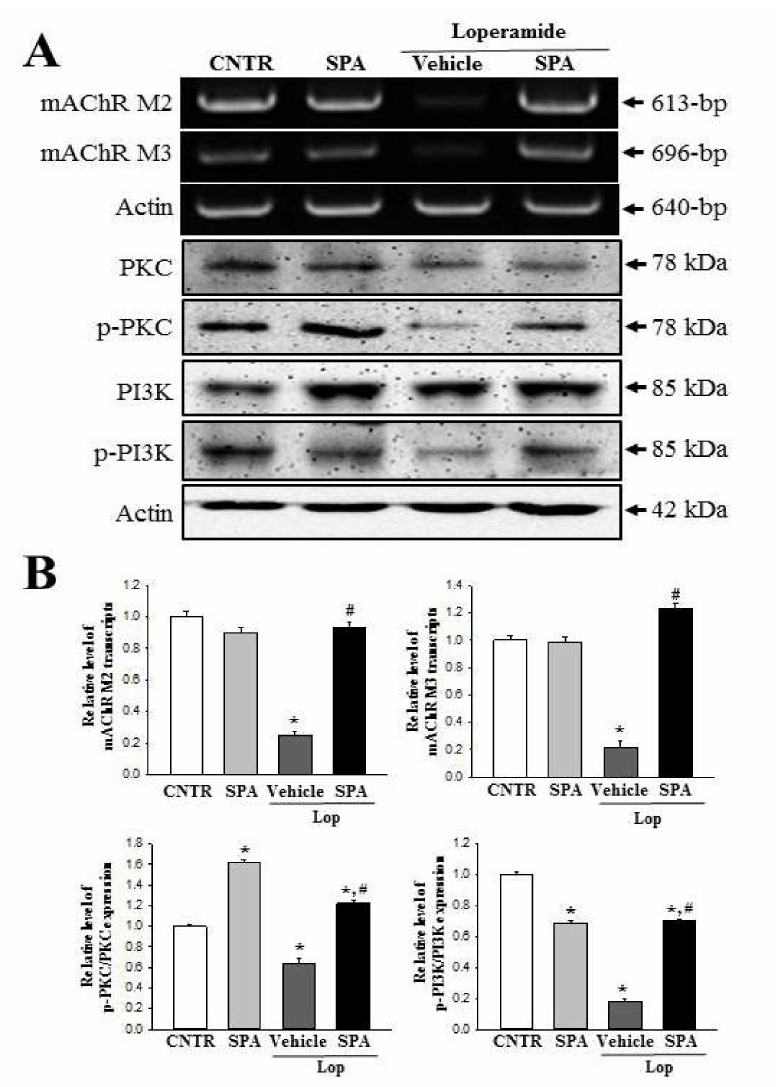
Figure 9. The expression of mAChRs and key mediators within their downstream signaling pathway in the colon after SPA treatment: ( A ) Resulting image of RT-PCR and western blot analyses. The levels of mAChR M2 and M3 transcripts in the total mRNA of colons were measured by semiquantitative PCR using specific primers. After the intensity of each band was determined using an imaging densitometer, the relative levels of mAChR M2 and M3 were calculated based on the intensity of actin. The expression of several related proteins, including PKC, p-PKC, PI3K, and p-PI3K, in the mAChR M2 and M3 signaling pathway were measured by a Western blot analysis using the HRP-labeled anti-rabbit IgG antibody. ( B ) Relative level of each protein expression. After the intensity of each band was determined using an imaging densitometer, the relative levels of the four proteins were calculated based on the intensity of actin. Five to six rats per group were used in the preparation of the protein and RNA, and the western blot and RT-PCR analyses were assayed in duplicate in each sample. The data are reported as the mean ± SD. * indicates p < 0.05 compared to the CNTR group. # indicates p < 0.05 compared to the Lop + Vehicle-treated